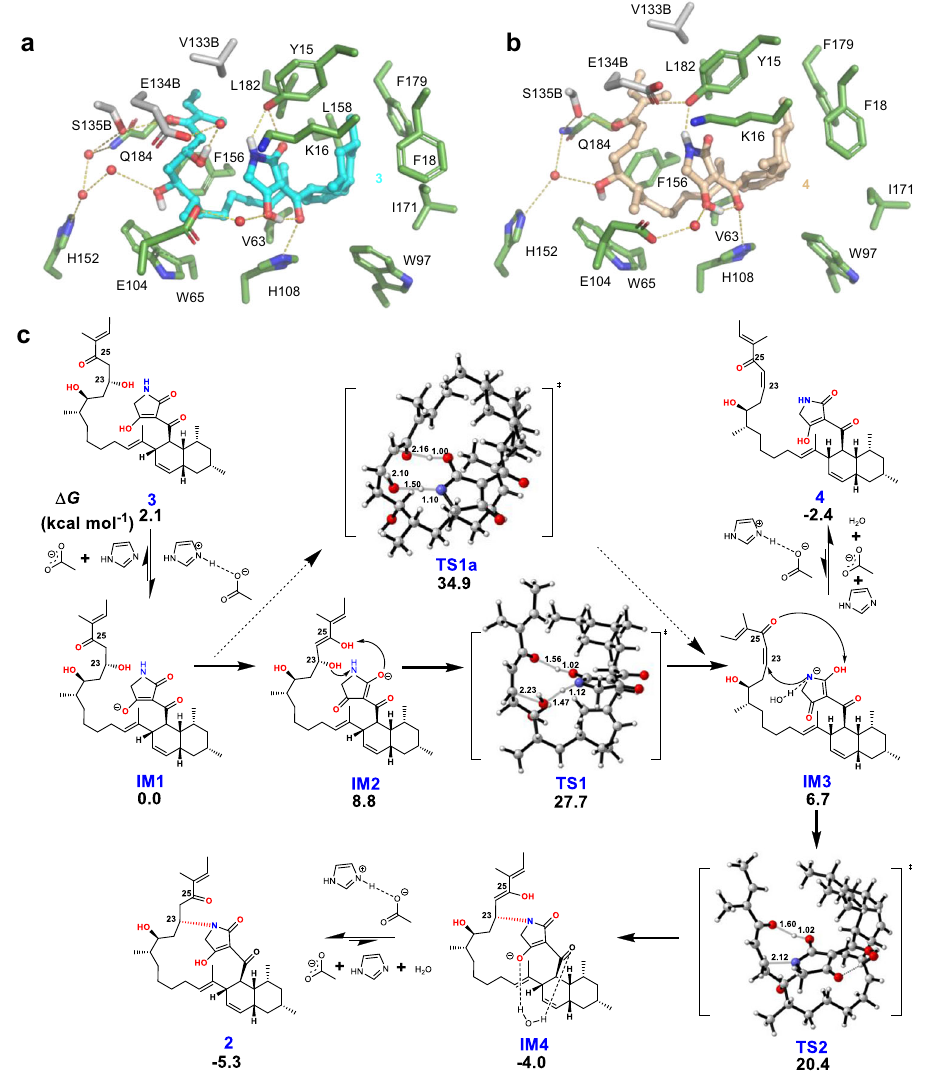
Fig.4|MDandDFTanalysis.a , b Close-upviewofMDrepresentativesnapshotsof AvmM active site complexed with 3 and 4 . Water molecules are shown in red spheres and hydrogen bonds are in gold dash lines. c DFT-computed Gibbs free energies (in kcal mol − 1 ) at the CPCM(water)-B3LYP-D3/6-311++G(2d,p)//